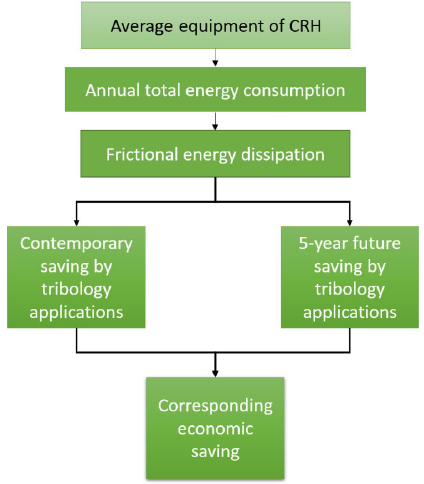
Fig. 15 Methodology